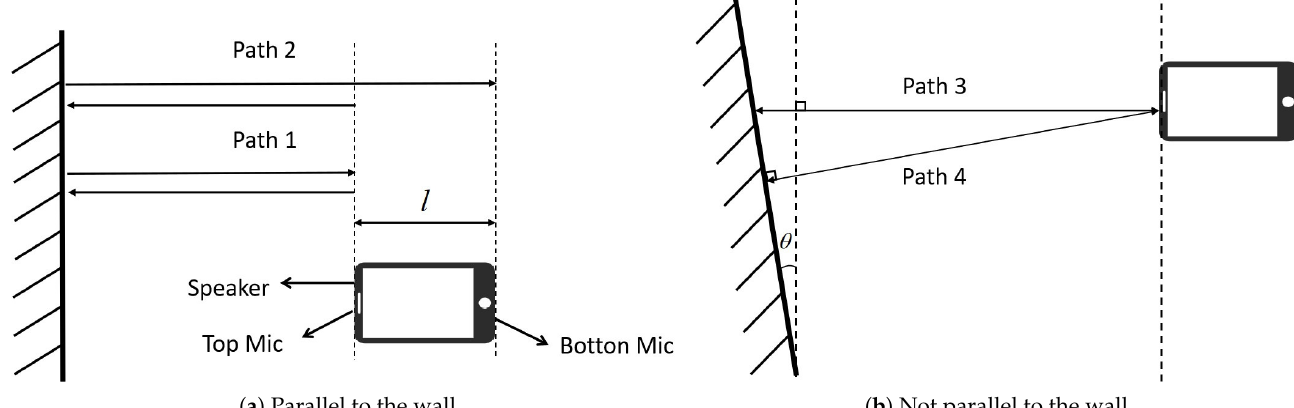
Figure 3. The position of the speaker and microphones, and the sound signal propagation path received by the microphone. ( a ) Sound signal propagation path when smartphone is parallel to the wall. ( b ) Sound signal propagation path when smartphone is not parallel to the